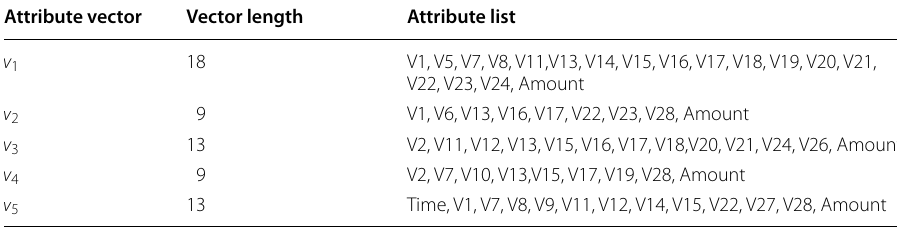
Table 1 GA Selected features Attribute vector Vector